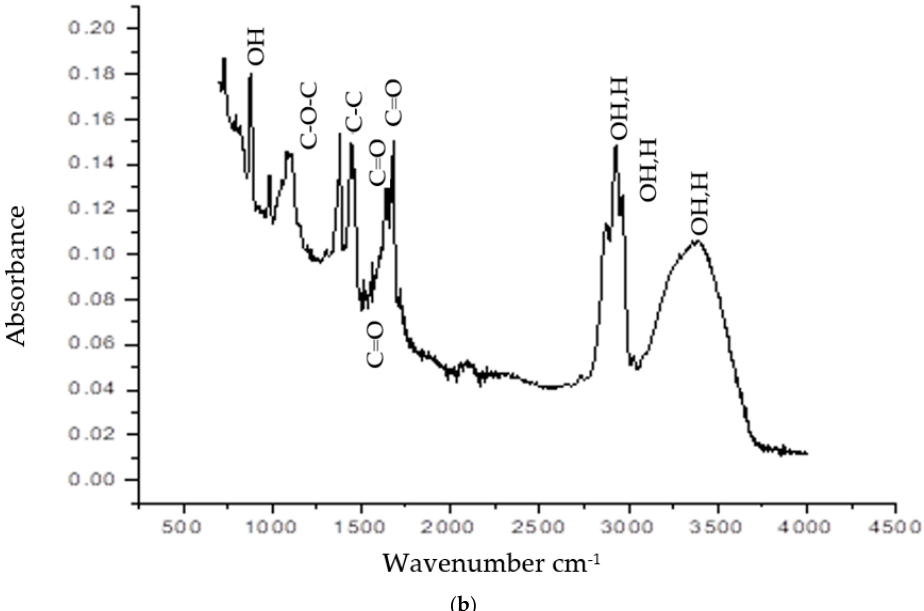
Figure 2. ( a ) The Raman spectrum ( b ) FTIR spectrum of ginger essential oil.